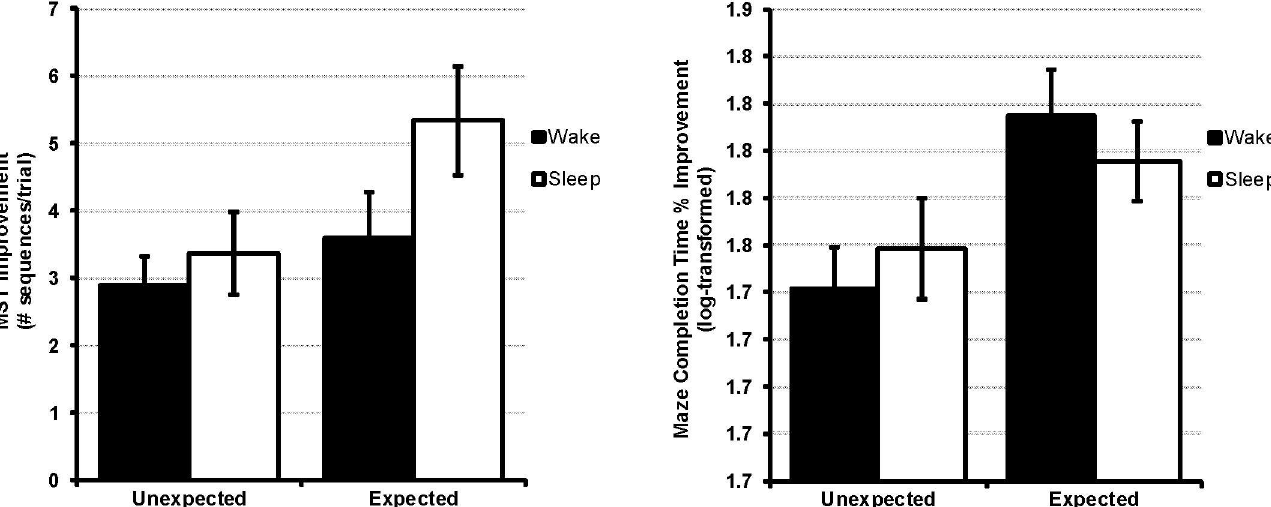
Fig 3. Expectation Equivalently Affects Memory across Both Wake and Sleep. The effect of expectationon memory consolidation was expressedequally across wake and sleep delays. Error bars ± SEM. For clarity, this Fig displays improvement from baseline.Statistical tests utilized an ANCOVA controllingfor baseline